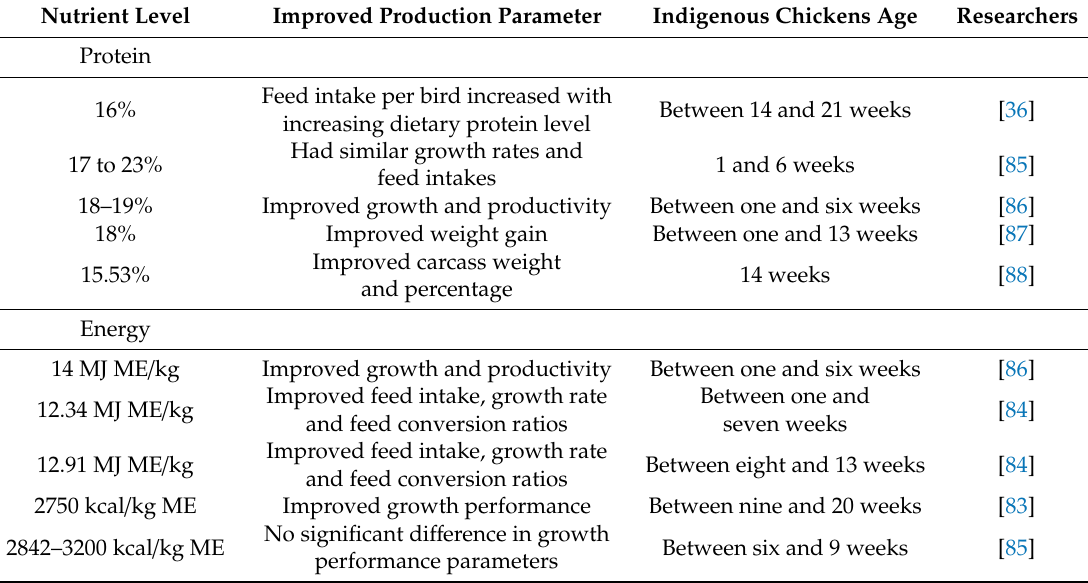
Table 3. Recommended protein and energy for improved productivity and performance among local